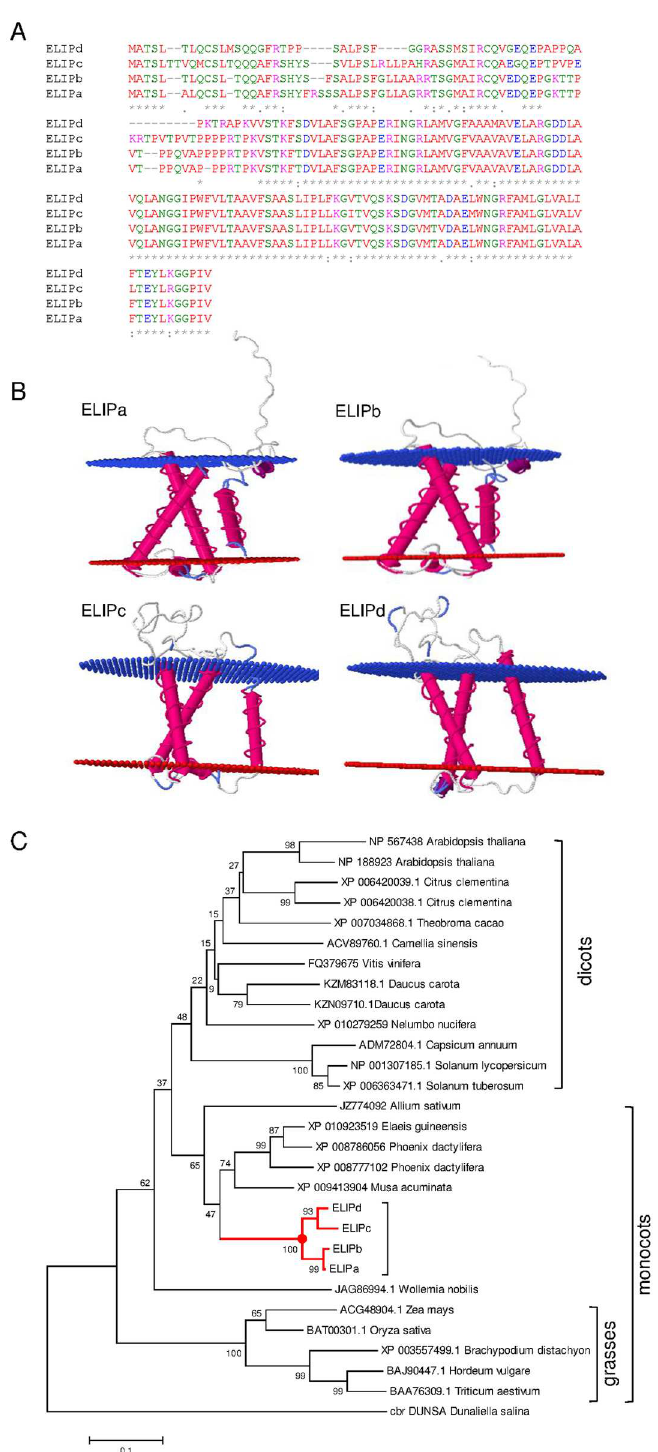
Fig 2. Comparison and analysesof ELIP proteins. (A) Amino acid alignmentof the four ELIP proteins isolatedfrom saffron stigmas. Conserved residues are depictedwith asterisk. The colors of the residues reflect their physicochemical properties:red for small (small+ hydrophobic (incl. aromatic -Y)); blue, acid; magenta, basic—H; green, Hydroxyl + sulfhydryl+ amine + G. (B) Tridimensional models of ELIPa-d and their dispositionin the membrane. (C) Phylogeneticanalysisof ELIP proteins. An un-rootedphylogenetic tree was